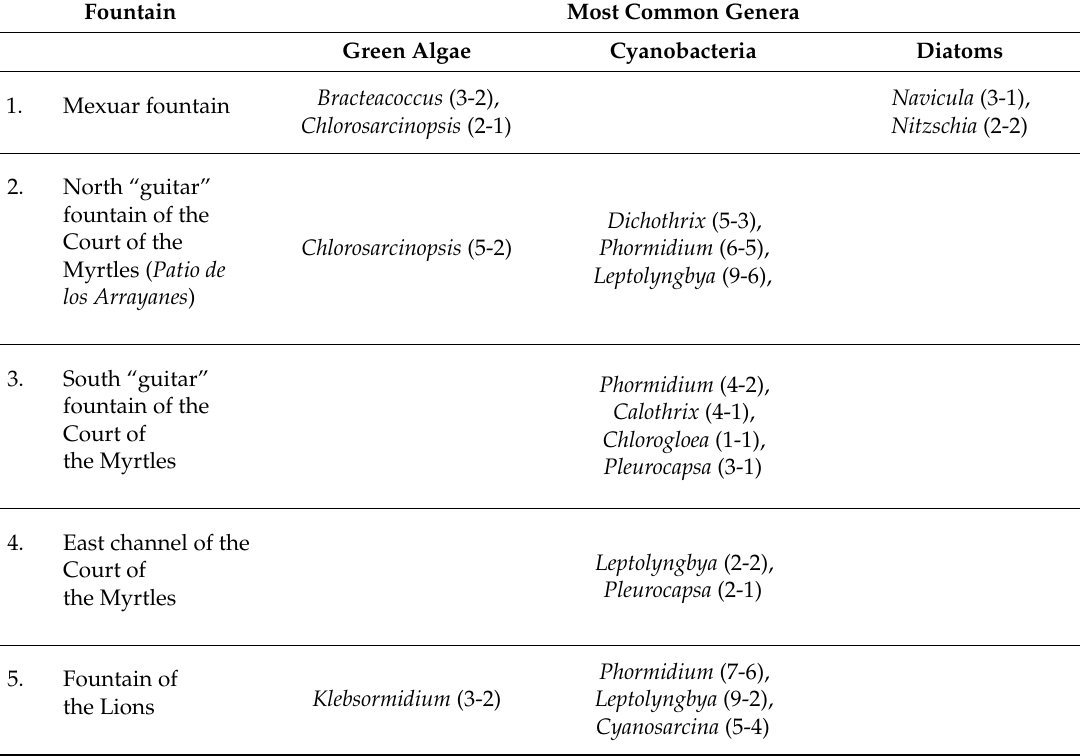
Table 2. The most common genera of microalgae in each of the fountains studied. For each fountain, the set of samples taken was considered, along with the di ff erent sampling points, and where applicable the di ff erent times of year. The genera that appear most often and in greater abundance were chosen. For each genus, the total number of samples in which it is present (first number) and the number of samples in which its index is 3 or higher (second number; see 2.2. Procedures) are shown in